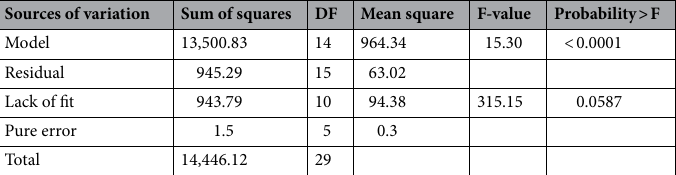
Table 5. Analysis of variance (ANOVA) for quadratic model for cobalt adsorption. R